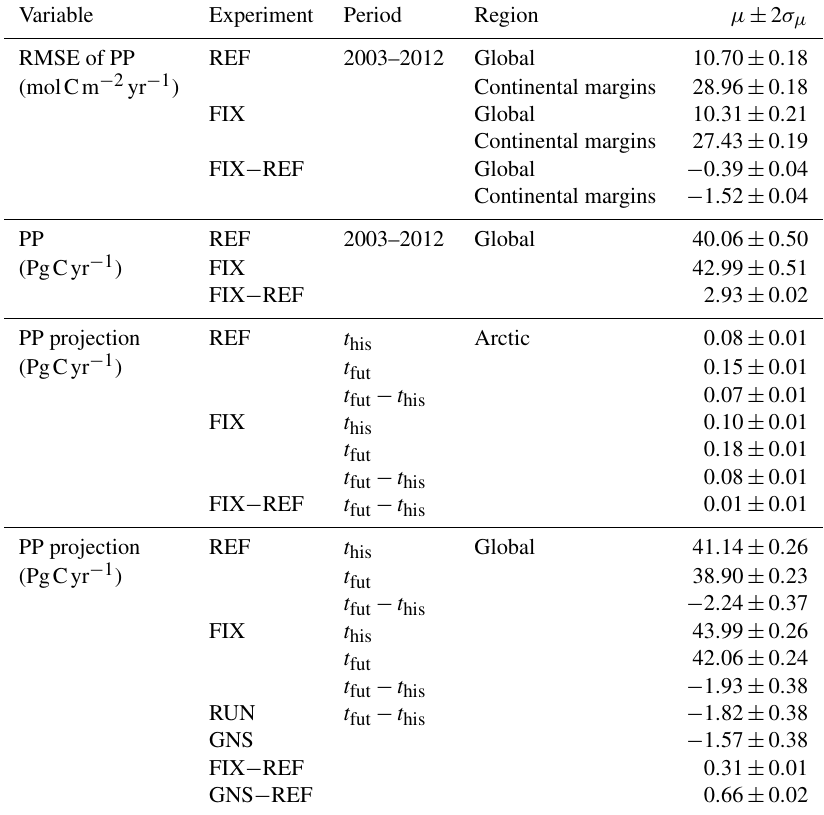
Table B1. Global and regional statistics of simulated primary production. Shown are the time mean µ and twice its standard deviation σ µ (rounded up to two decimals) derived from annual values. The t his and t fut denote the time periods 1950–1999 and 2050–2099,